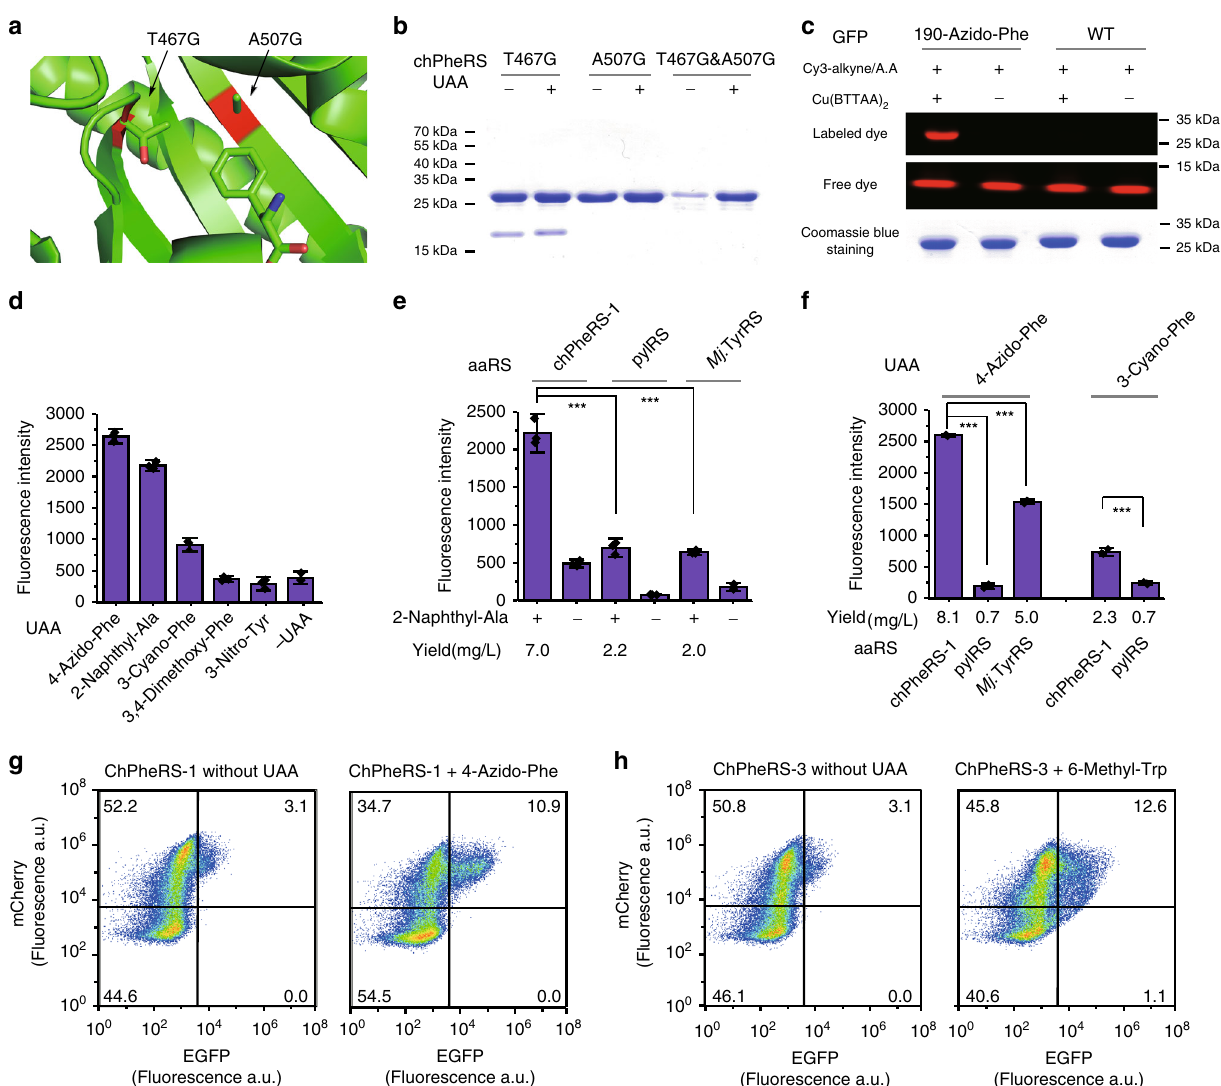
Fig. 5 Incorporation of Phe and Tyr analogues with the chimeric PheRS/tRNA pair. a Structure of human mitochondrial PheRS amino acid binding pocket, in which two gate-keeper residues are highlighted in red and shown sticks. b Analysis of amber suppression activity of the chPheRS variants to 4-Azido-Phe by detecting expression of full-length GFP. The major band in Coomassie blue staining gel is the full-length GFP. c GFP site-speci fi cally installed 4-Azido- Phe is labelled with Cy3-alkyne with Cu(BTTAA) 2 as a ligand and ascorbic acid (A.A) as a reducing agent. Wild-type GFP is used as a negative control. d Analysis of amber suppression activity of chPheRS-1 by GFP reporter assay with 1 mM of indicated UAAs. e Comparison of the incorporation ef fi ciency of 2-Naphthyl-Ala in E. coli DH10B cells with chPheRS-1, pylRS 51 and Mj .TyrRS 53 (from left to right, p = 1.56E-4 and 9.29E-5). The puri fi ed protein yield is shown below the fi gure. f Comparison of the incorporation ef fi ciency of 4-Azido-Phe, and 3-Cyano-Phe with chPheRS-1, pylRS variants 50 , and Mj .TyrRS 52 (from left to right, p = 2.19E-8, 3.40E-7 and 5.32E-5). The puri fi ed protein yield is shown below the fi gure. Flow cytometry analysis of amber suppression ef fi ciency of chPheRS-1 ( g ) and chPheRS-3 ( h ) in mammalian cells with or without the addition of 2 mM of indicated UAAs. Error bars represented ±standard deviation of the mean ( n = 3). Statistical signi fi cance is quanti fi ed with ordinary one-way ANOVA (*** p < 0.001). Source data are available in the Source Data fi